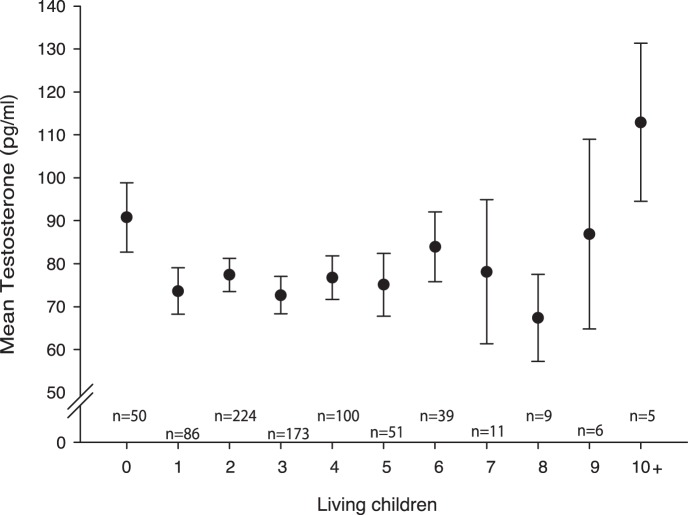
Number of living children and mean testosterone level for Caucasian men (n = 754).Error bars represent 95% Confidence Intervals (10+ is only used for graphical representation analyses used the full range).